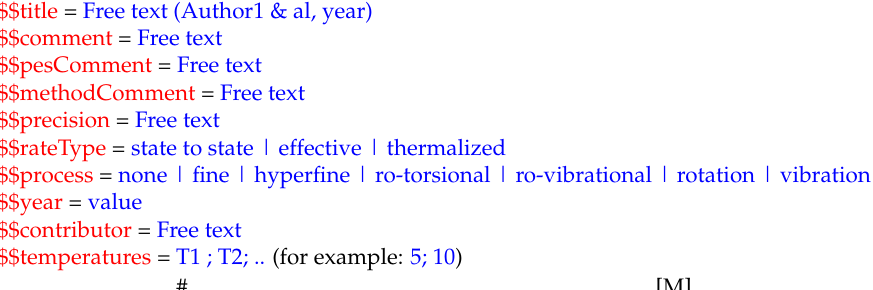
Table A4. Template of a “Rate Coefficients” input as requested by the import script. The metadata are in red and the values in blue. In the second part of the table, all fields are mandatory. The first column corresponds to the target’s initial level, the second column to the target’s final level, the third column to the collider’s initial level, and the fourth column to the collider’s final level. Then, the rate coefficients at the different temperatures indicated as values of the parameter $$temperatures are provided. In the current template, the transition is between the third and the first rotational levels of a target with the collider in its fundamental state. Two temperatures are considered at T1 and T2. The values 0.130607E-10 and 0.161225E-10 are the rate coefficients in cm 3 s − 1 .